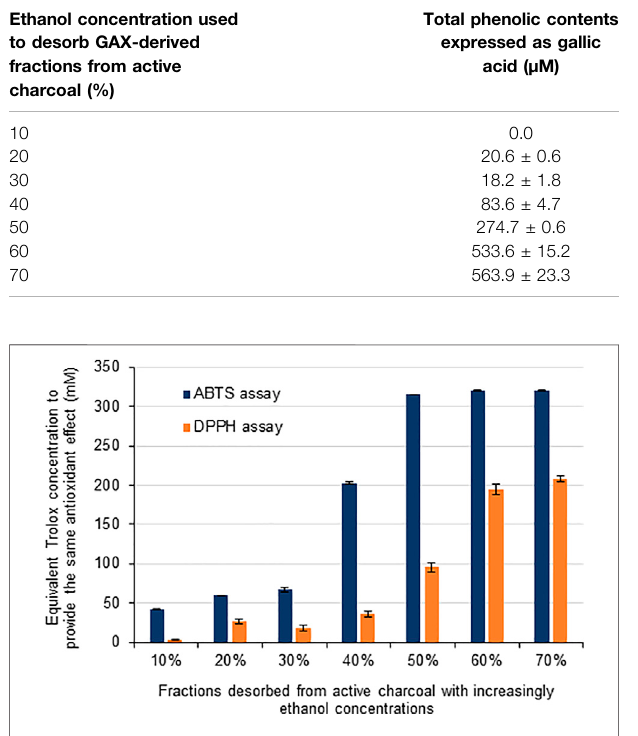
FIGURE 5 | Antioxidant activity of xylooligosaccharide fractions described in Table 3 .